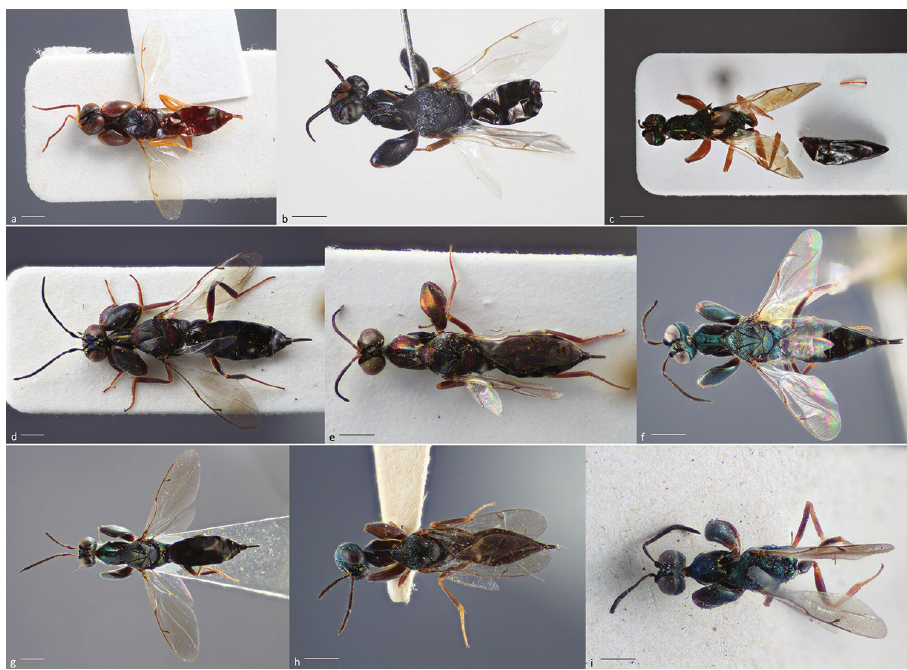
Figure 4. Habitus (dorsal) III a O. magnifica (Risbec) (imaged specimen: OMag01, holotype) b O. mkomaziensis sp. n. (OMk01, holotype) c O. monstrum syn. n. (OFo12, paratype) d O. namibiensis sp. n. (ONa01, holotype) e O. niehuisorum sp. n. (ONi01, holotype) f O. pumilae Yang (OPu01, paratype) g O. regiae Yang (ORe01, paratype) h O. srilankiensis sp. n. (OSr01, holotype) i O. tenuicollis (Walker) (OTe01, holotype). Scale bars: 1